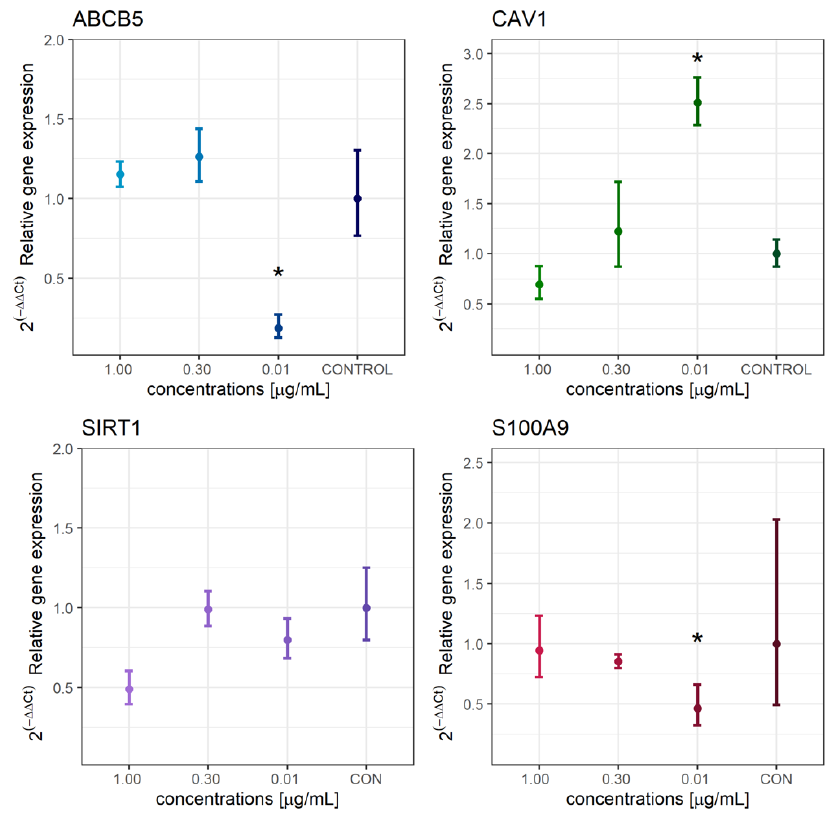
Figure 4. Analysis of relative expression of target genes ABCB5 , CAV1 , SIRT1 and S100A9 in WM-266-4 cells exposed to different concentrations of extract (1.00 µg/mL, 0.30 µg/mL and 0.01 µg/mL)